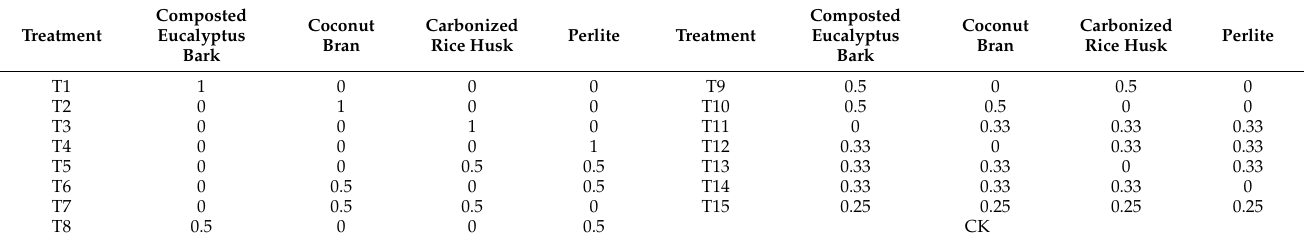
Table 1. Substrate mixture